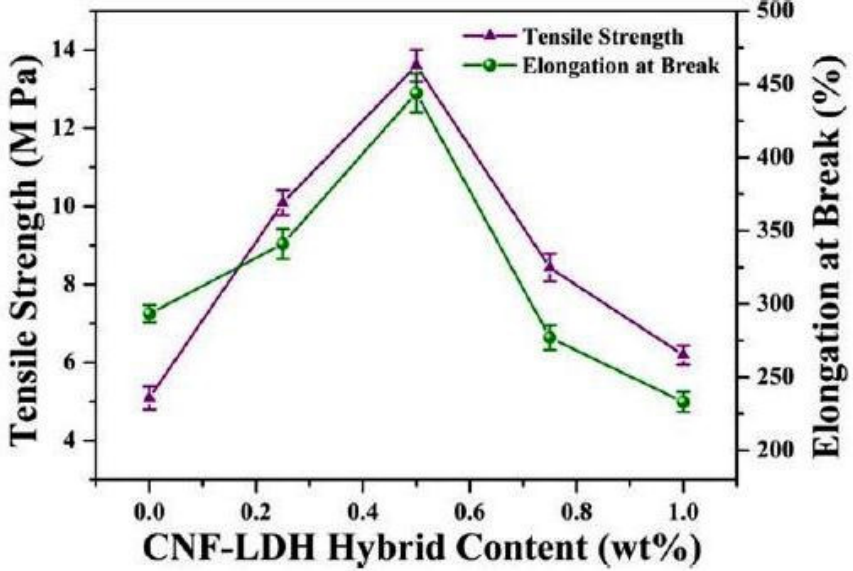
Figure 15. Variation of the tensile strength and elongation at break of the TN nanocomposites versus the SFCNF-LDH hybrid content. Reproduced with permission from [113], Copyright Wiley, 2016.